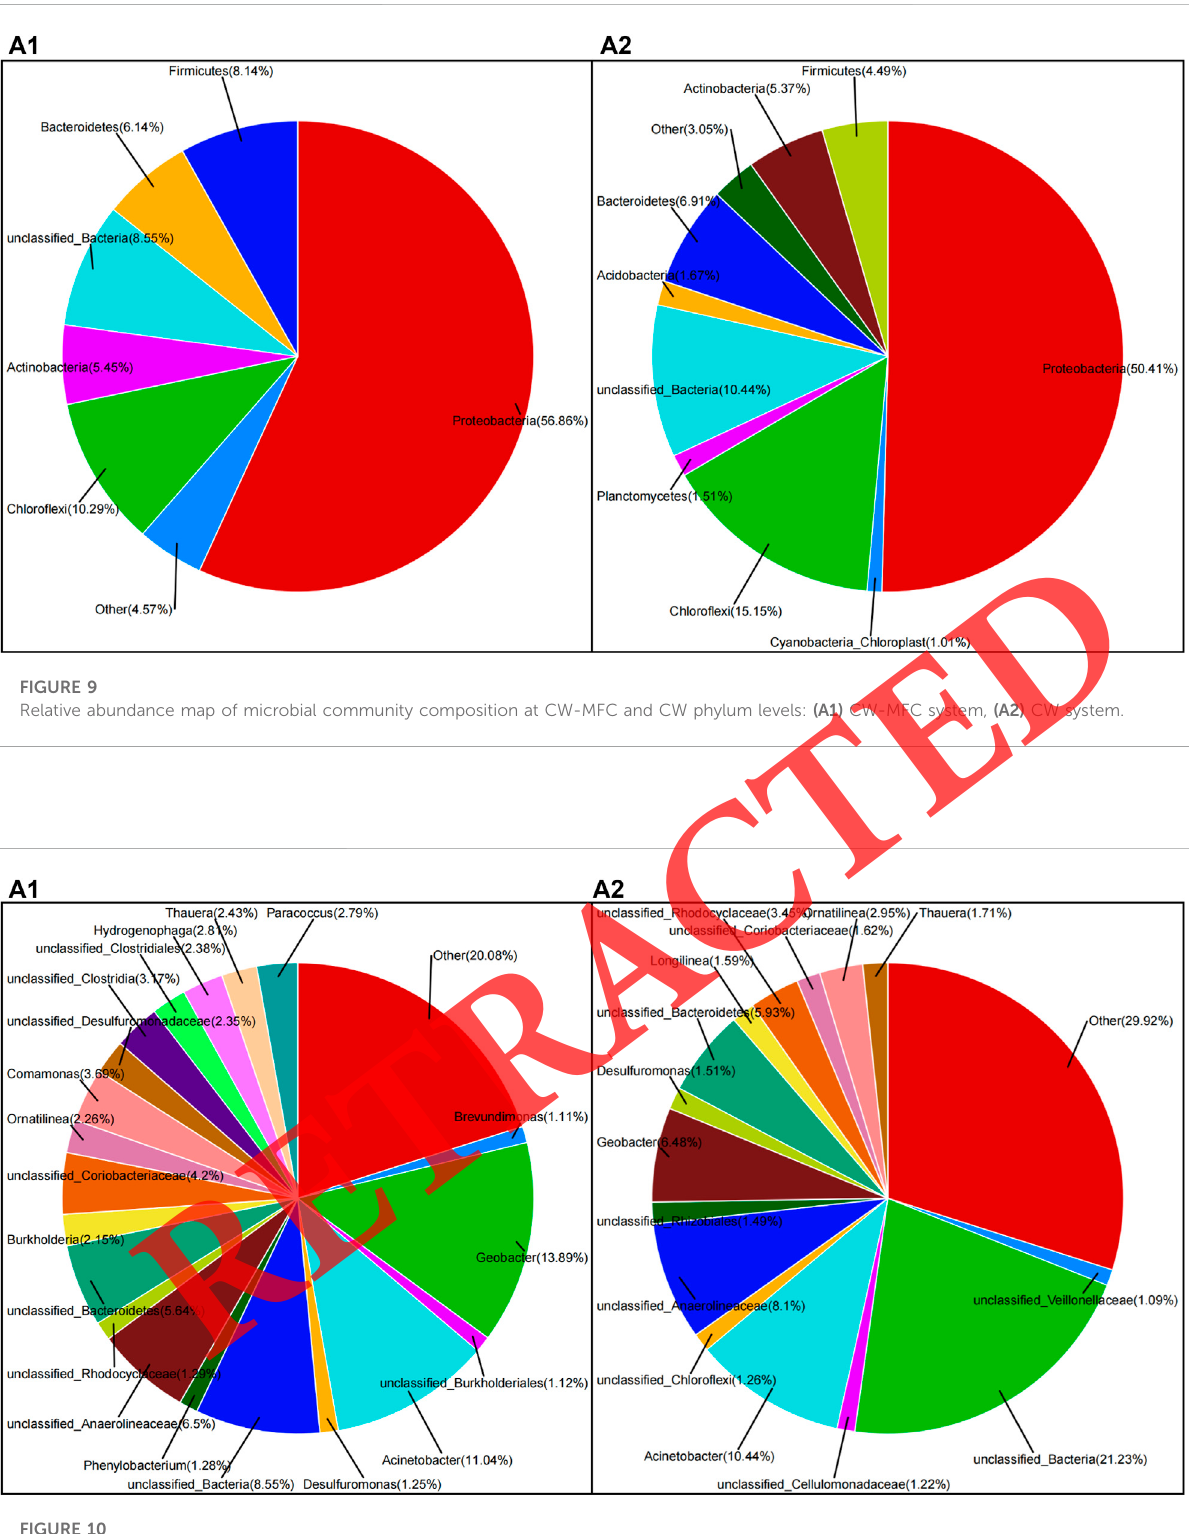
Relative abundance map of microbial community composition at CW-MFC and CW genus levels: (A1) CW-MFC system, (A2) CW